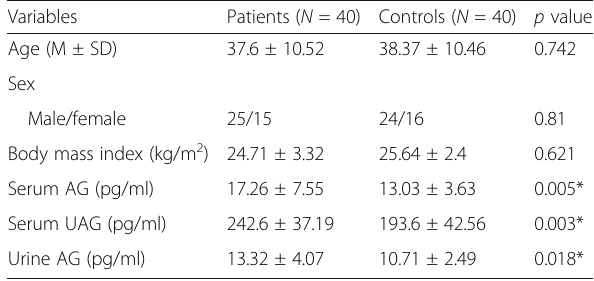
Table 1 Clinical characteristics and laboratory results of patients and